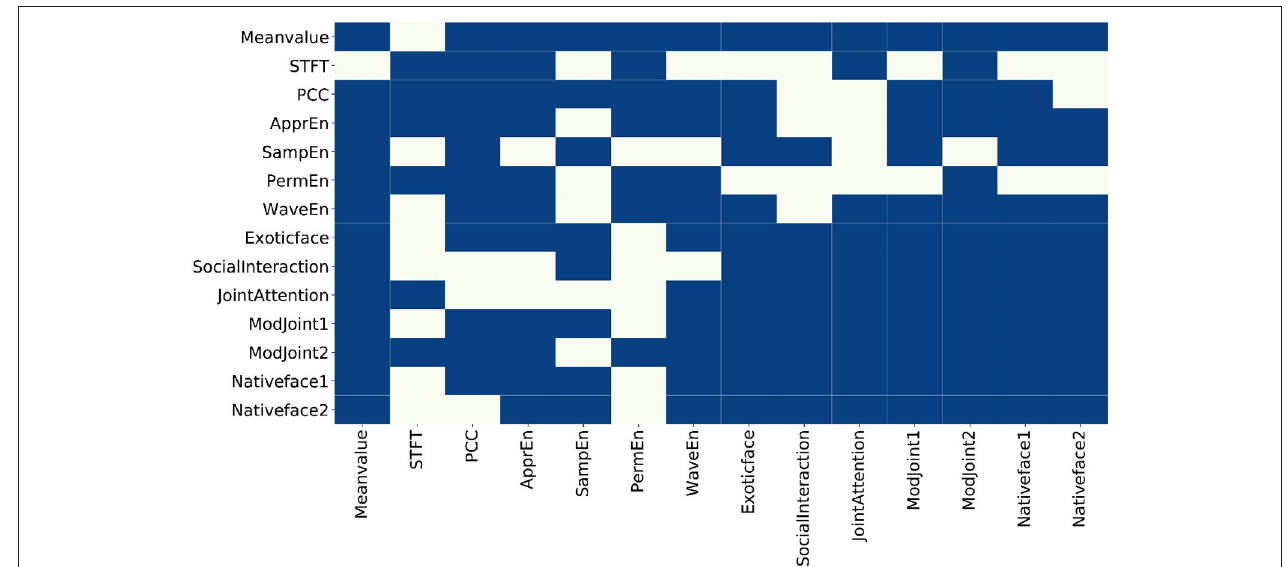
FIGURE 4 | The constructed adjacency matrix. The blue block means there is a connection between two nodes, and the beige block means there is no connection between the two nodes.